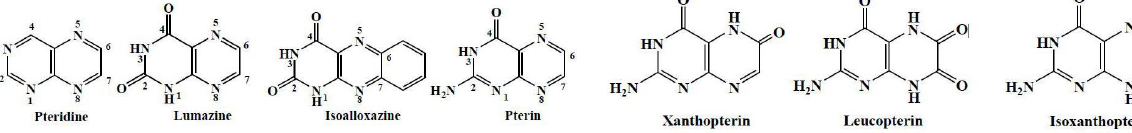
Figure 1: Different natural pterin moieties. Figure 2: Natural pterins.